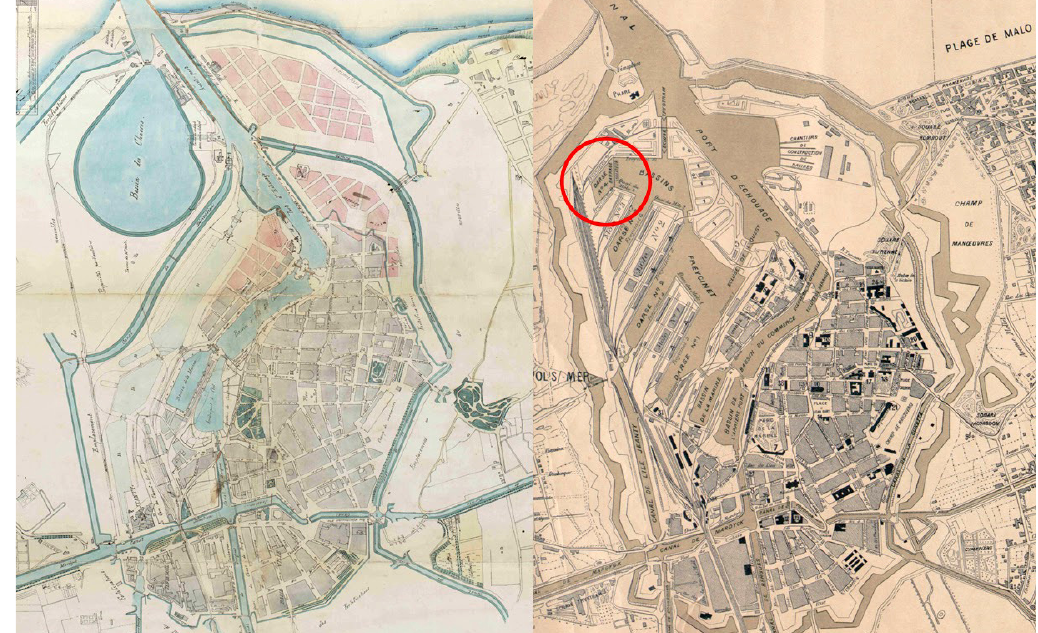
Figure 1. Maps of the port city of Dunkirk. On the left, Dunkirk in 1875, and on the right in 1910 after the modifications of the Freycinet Plan. The red circle highlights the location of the floating dam and the basin dedicated to oil, the furthest away from the city center. Source: Centre de la Mémoire Urbaine d’Agglomération (n.d.‐a,